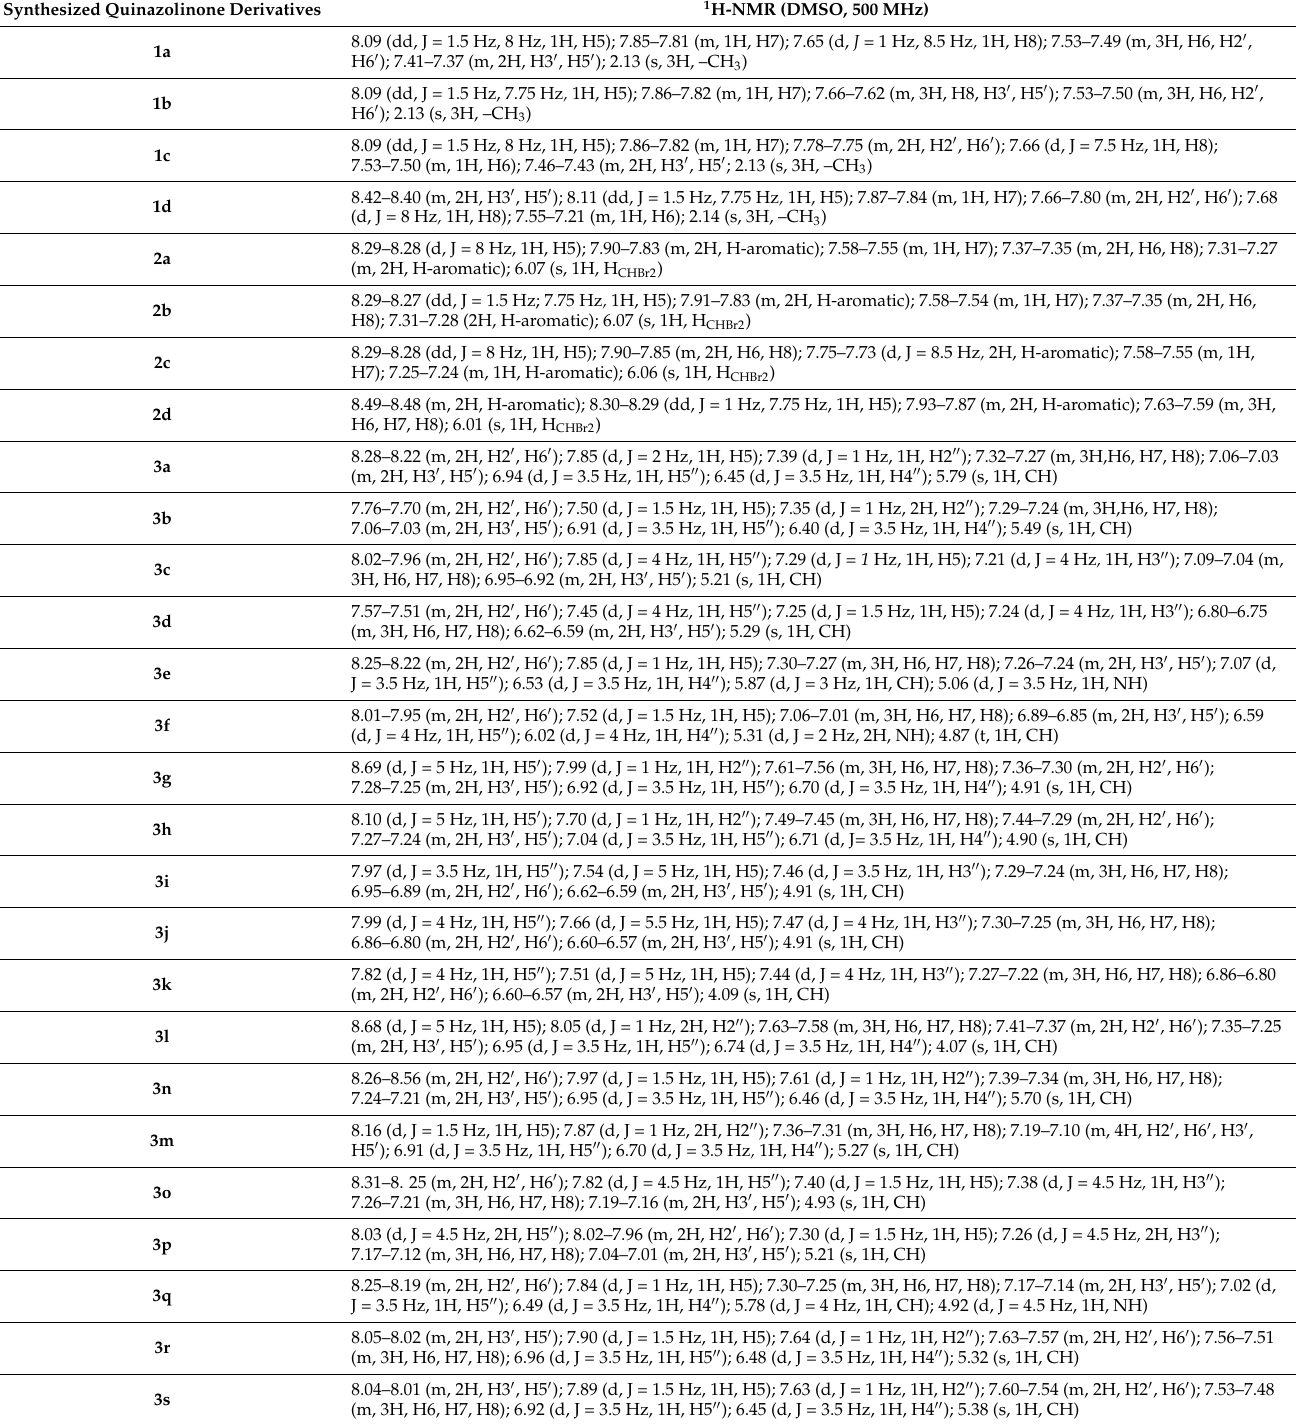
Table A1. 1 H-NMR (DMSO, 500 MHz) of the synthesized quinazolinone derivatives. Synthesized Quinazolinone